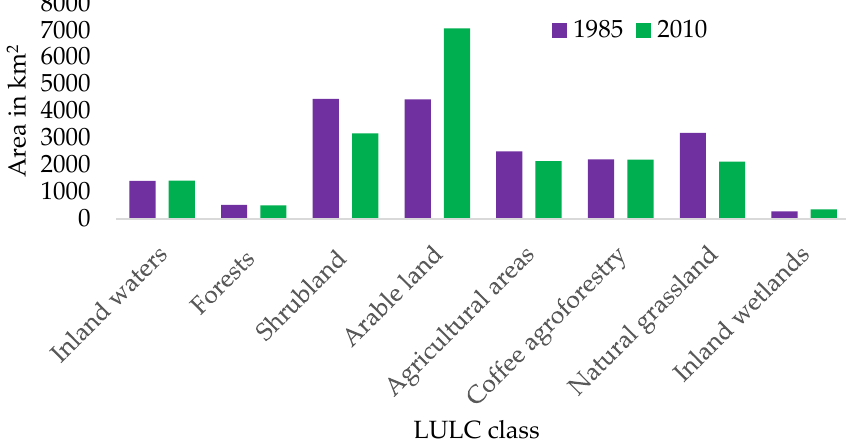
Figure 9. Changes in LULC from 1985 to 2010 in Abaya-Chamo Basin, Ethiopia. (Source of data: Woldeyohannes et al., 2020 [73], but figure done by authors).